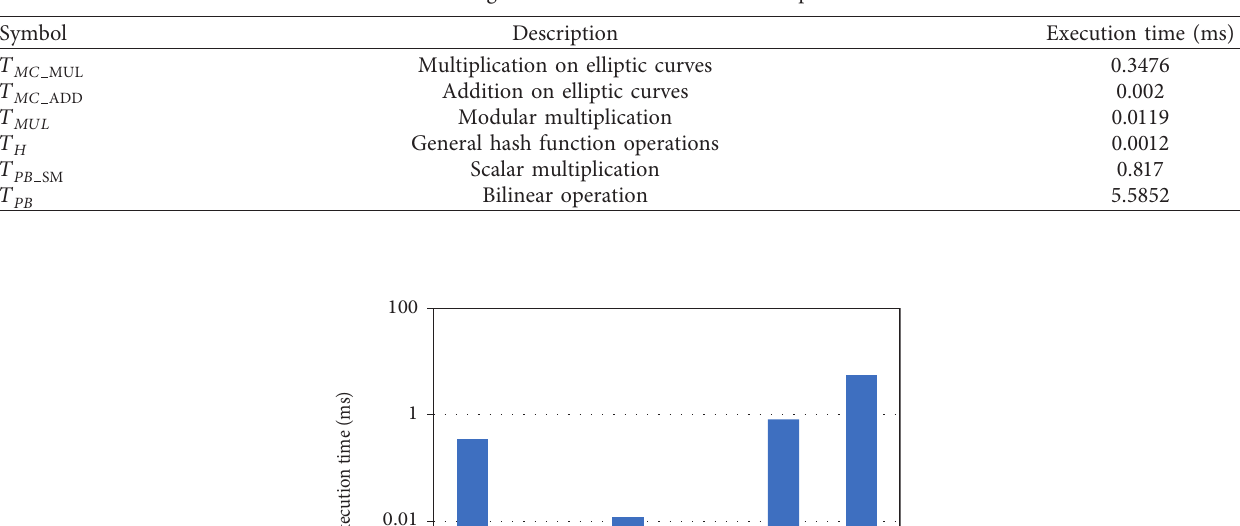
Table 2: Average execution time of simulation operations.